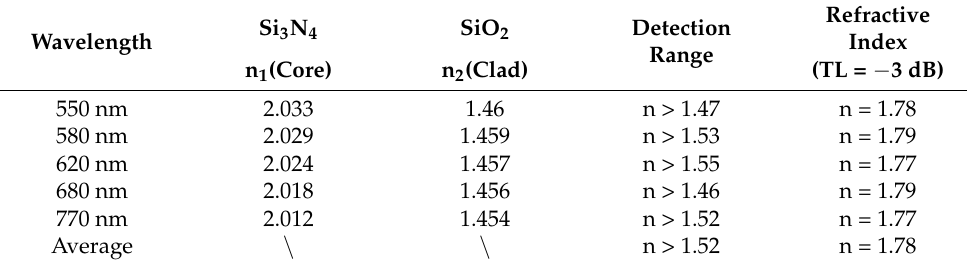
Table 2. The impact of light wavelength on the detection range.